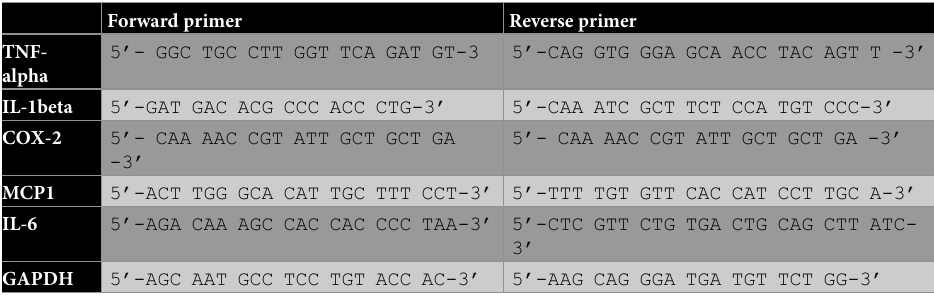
Table 1. PCR primer sequences. Primers used for